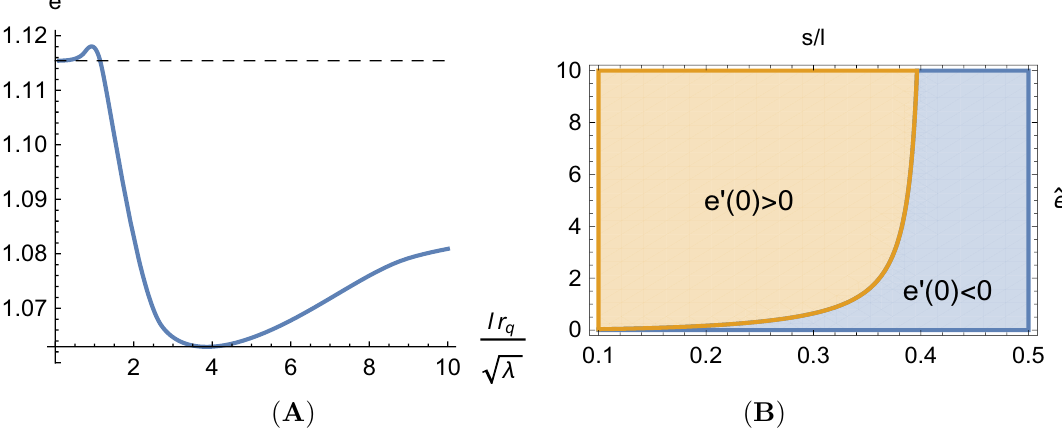
Figure 10 . ( A ) Extensivity e as a function of strip width l , with a (cid:12)xed ratio of strip separation to strip width ( s=l = 0 : 3); here e is calculated numerically for ^ (cid:15) = (3 = 4)( N f =N ) (cid:21) = 5 and the horizontal dashed black line corresponds to the analytical result (4.18). Note the small range of scales where the theory is more super-extensive than in the conformal UV ( l ! 0) and IR ( l ! 1 ) limits. ( B ) Domains in the f ^ (cid:15); s=l g parameter plane where the theory display greater super-extensivity than a CFT ( e 0 (0) > 0) or is always less super-extensive than a CFT ( e 0 (0) < 0). Analytical results indicate that for ^ (cid:15) = 0, e 0 (0) < 0 for all s=l and in the ^ (cid:15) ! 1 limit the derivative changes sign at s=l (cid:24) 0 : 406 (the solution of (4.19) for b = 5 =